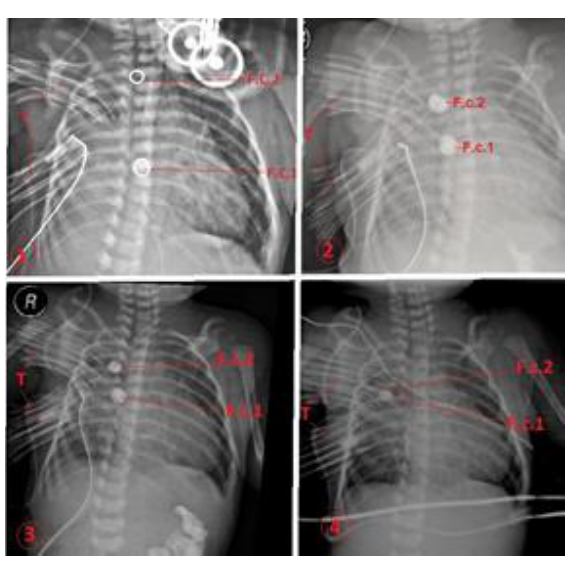
Figure 3: Serial chest x-rays (1-4) showing the progress of the balloons of the